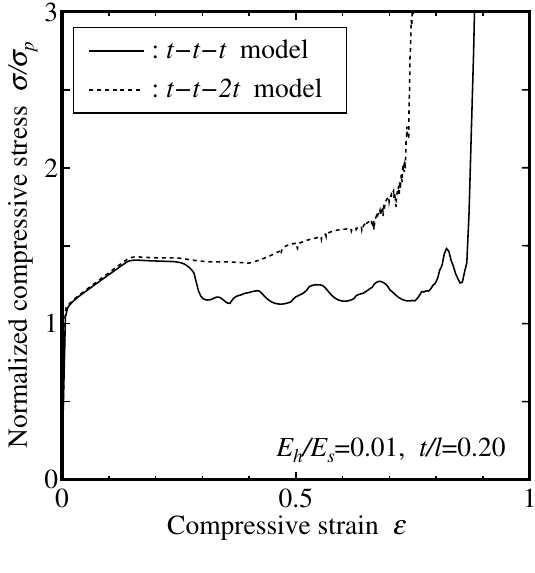
Figure 14. Stress-strain responses of Type I for the t - t - t and t - t - 2 t models.